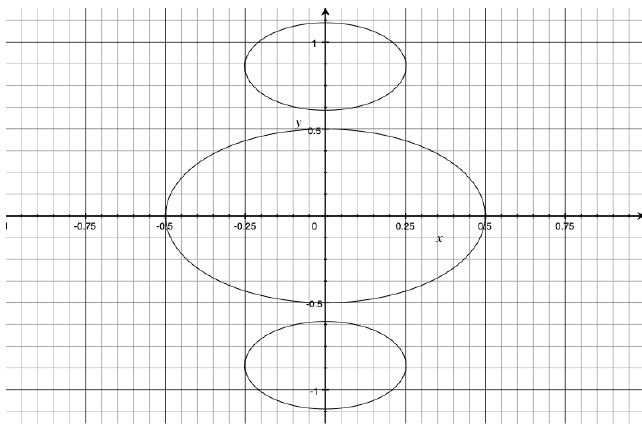
Figure 6. Workspace representation of the three circles with their punctual strains.